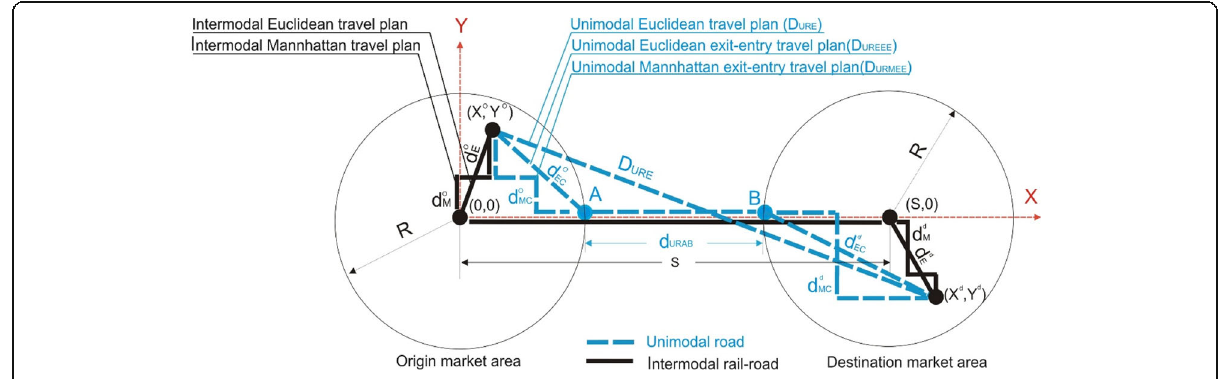
Fig. 2 Travel plans between two separated market